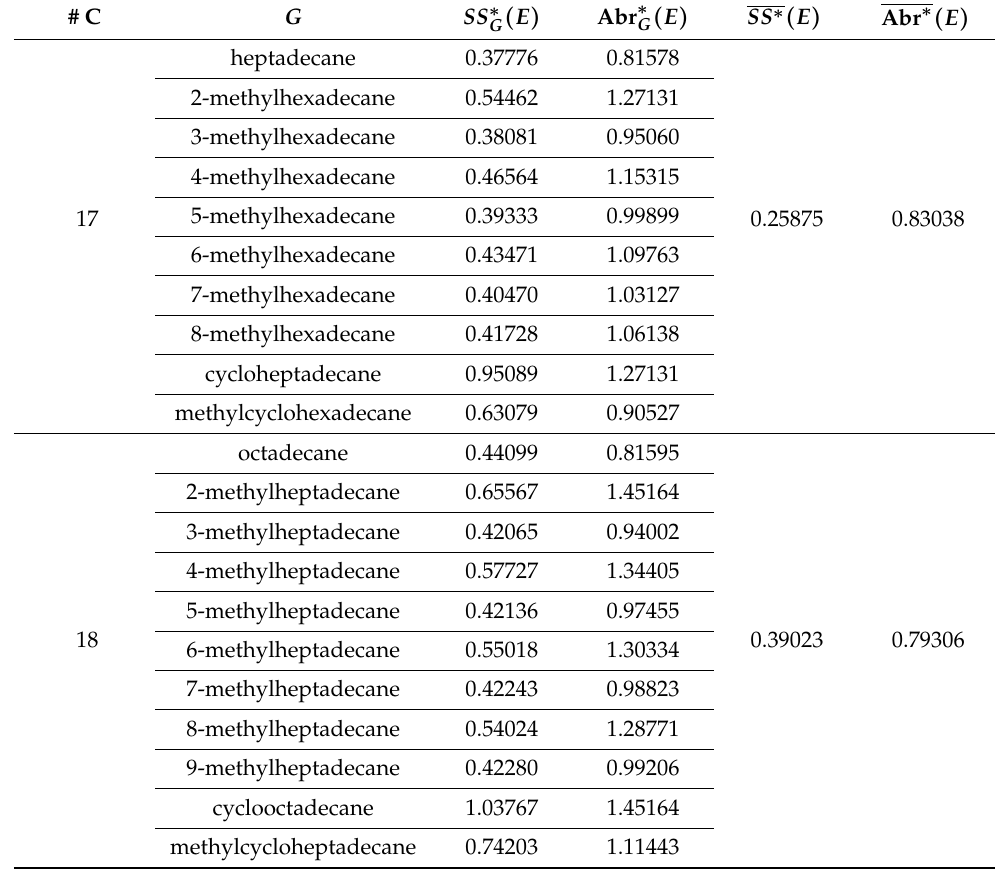
Table A4. Modified structure sensitivity and modified abruptness with average values, Part